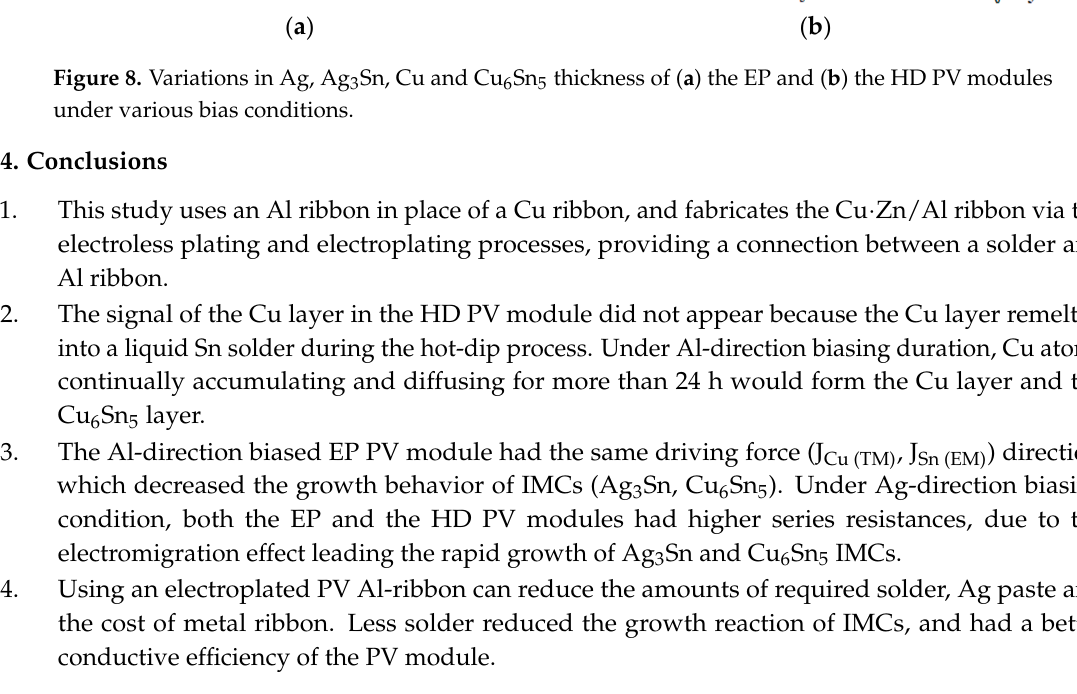
Figure 8. Variations in Ag, Ag 3 Sn, Cu and Cu 6 Sn 5 thickness of ( a ) the EP and ( b ) the HD PV modules under various bias conditions.